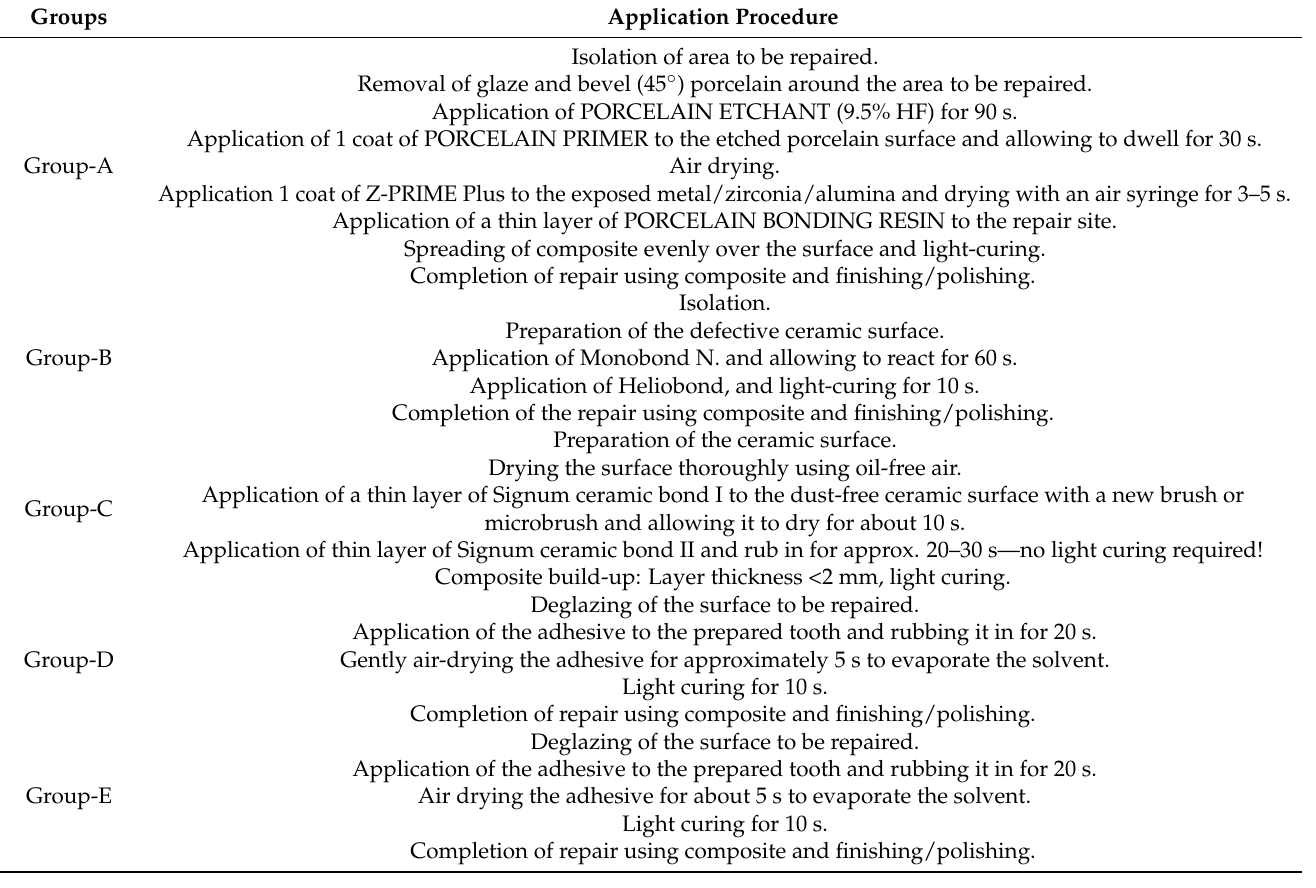
Table 2. Details of the repair procedures used for each of the five test groups.